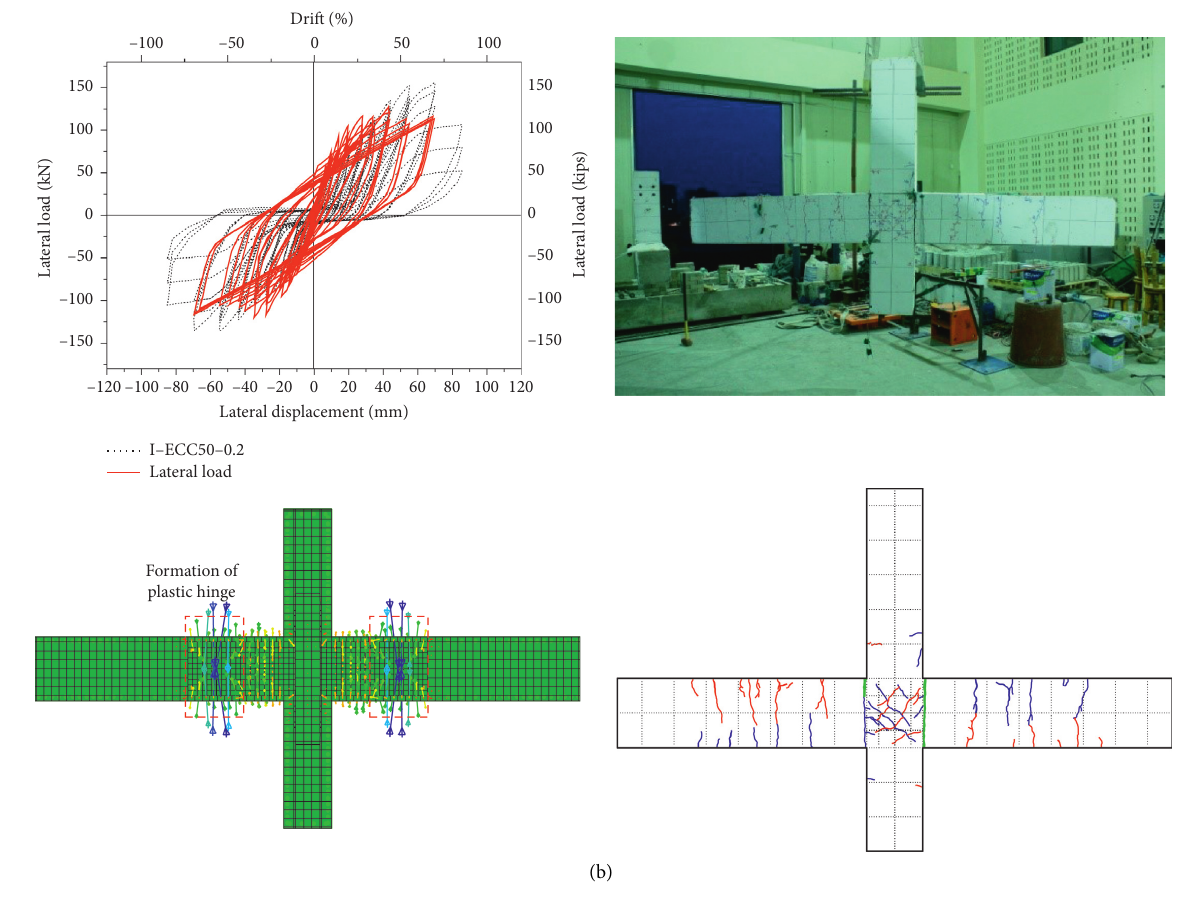
Figure 4: Test and analysis results. (a) RC-control. (b) PC-I50-0.2.